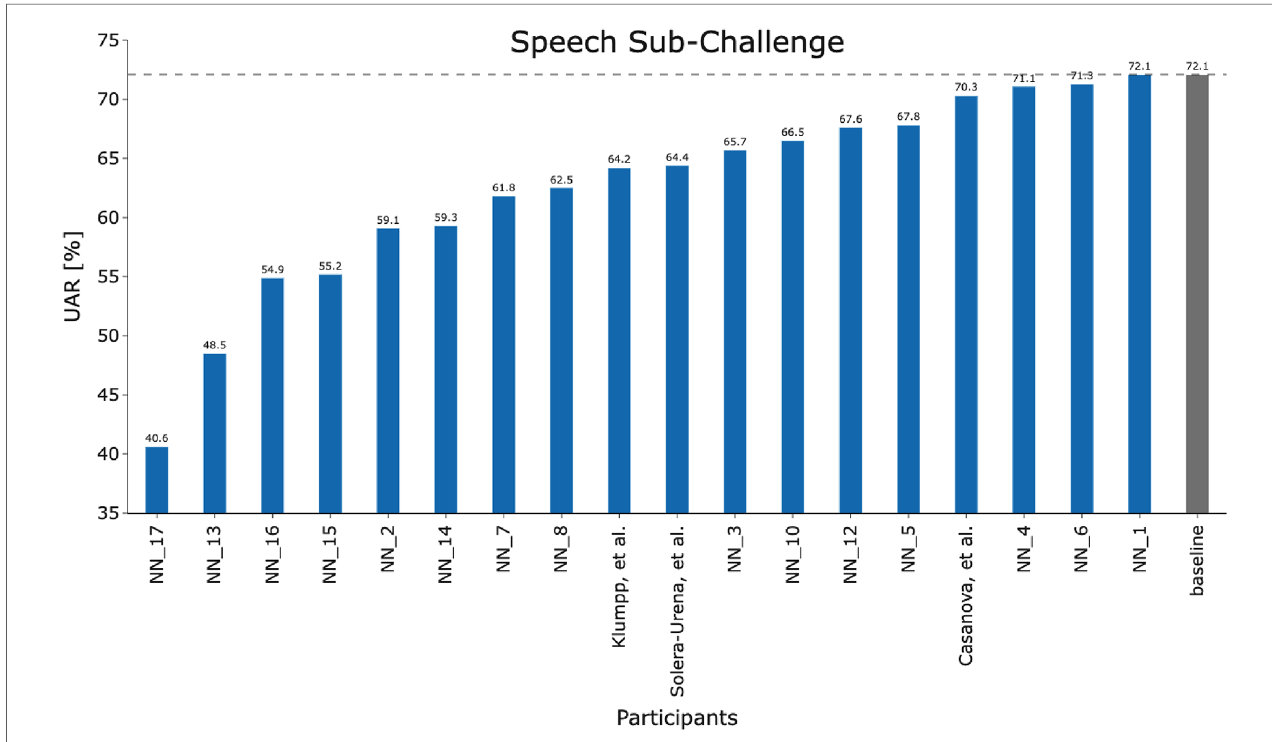
FIGURE 3 Team performance on the held out test set for the COVID-19 Speech